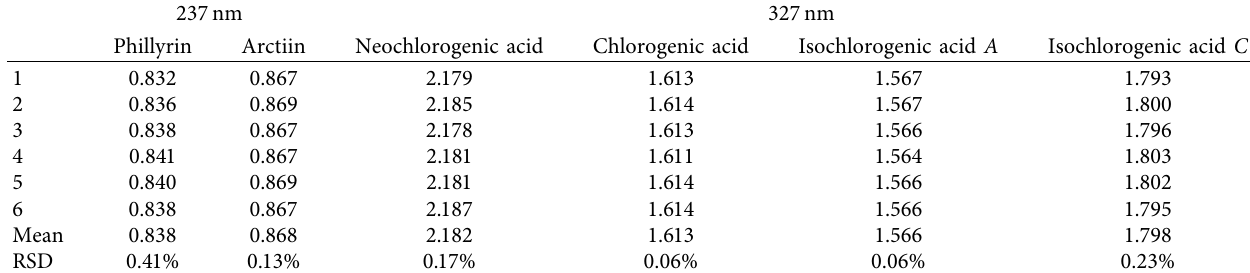
Table 7: Te RCFs of components at 237 nm and 327 nm.